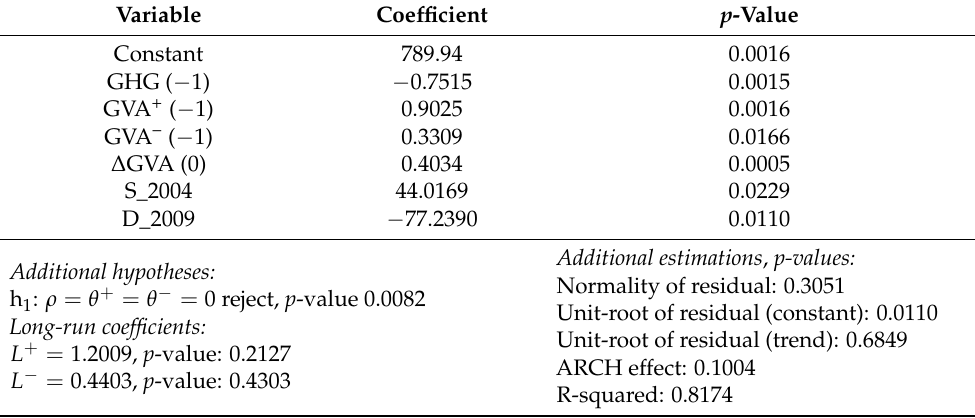
Table A4. NARDL results for Estonia after sequentially omitting insignificant